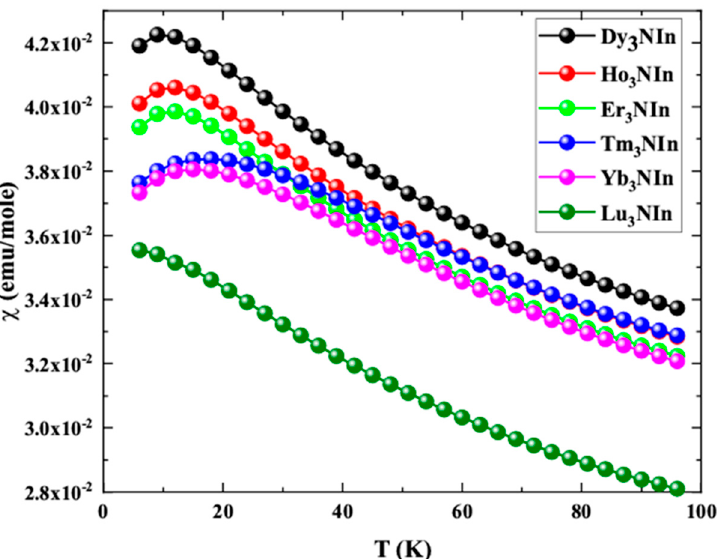
Figure 11. Magnetic susceptibility of the rare earth nitrides Ln 3 NIn (Ln = Dy-Lu) anti-Perovskite.